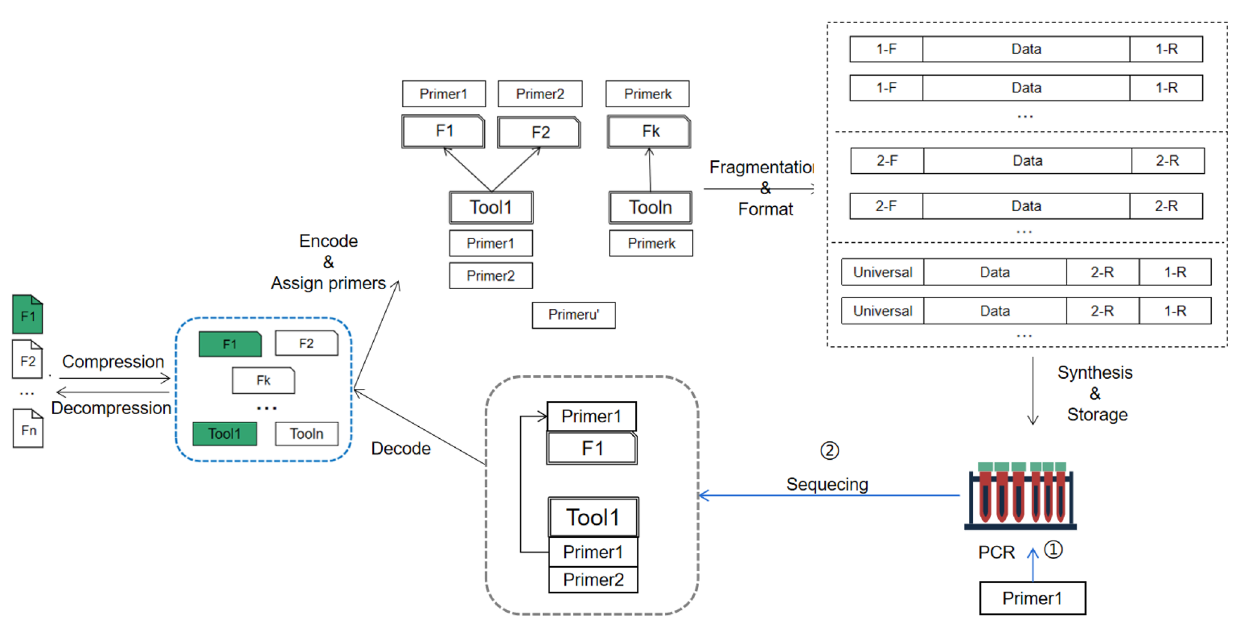
Figure 5. 1-MCI Method: The procedure prior to assigning primers is the same as that of M-1CI. Logically, 1-MCI no longer assigns a specific primer to each tool, rather, all the tools share the same universal primer and include all the primers used in their own data files. The specific implementation is reflected in the sequence after the segmentation is performed, the fragments of all the tool files contain the data file primers and the universal primers of the tools applied to the data files. Suppose if F1 needs to be read, Step 1 (cid:31) is to amplify it by Primer1 , then in Step 2 (cid:31) , sequencing, decoding, and decompressing can be performed once to restore the original